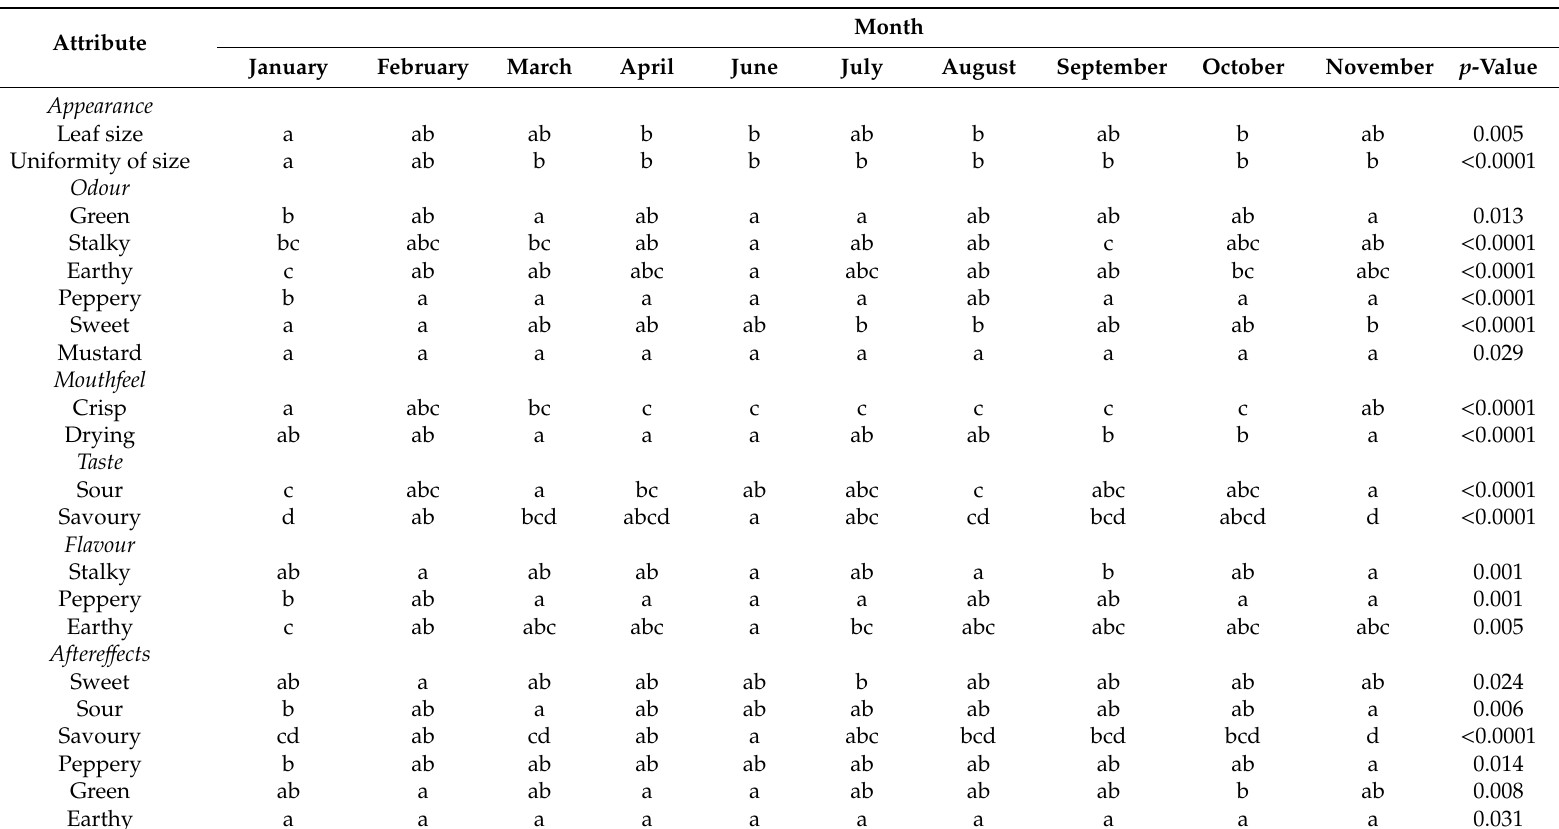
Table 2. Analysis of variance (ANOVA), Tukey’s honest significant di ff erence (HSD), and pairwise comparison data for sensory attributes of rocket salad leaves supplied to the United Kingdom over the course of one